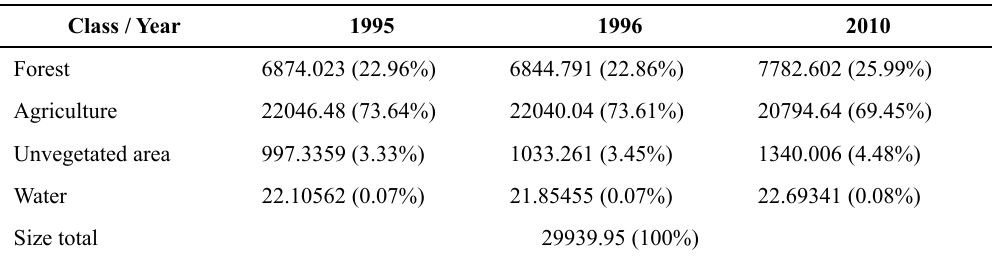
Table S1. Area size in hectare and percentage of total area (in parentheses) showing changes in land uses in Viçosa municipality -MG, Brazil, classified in 1995, 1996 and 2010.